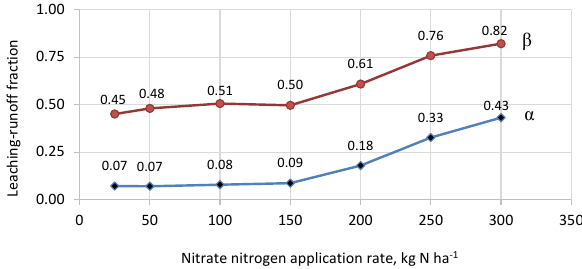
Figure 7. The N leaching–runoff fractions α and β calculated per N application rate for the reference management